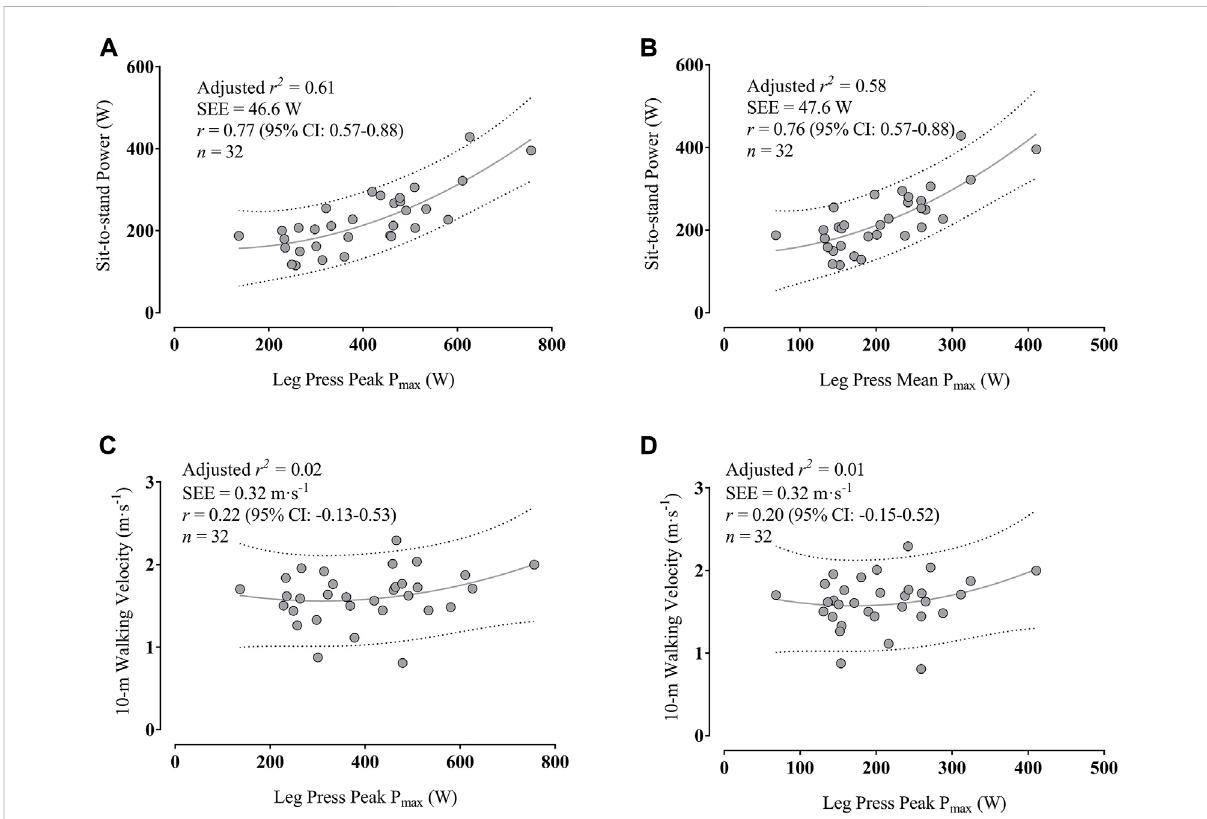
FIGURE 5 Associationsbetweenmaximalpeakpower (A) andmeanpoweroutput (B) inthelegpresswithsit-to-standpowerandbetweenpeakpower (C) and mean power output (D) with 10-m walking velocity; Dotted lines indicate the prediction intervals. Abbreviation: CI, con fi dence interval; P max , maximal power output; SEE, standard error of the